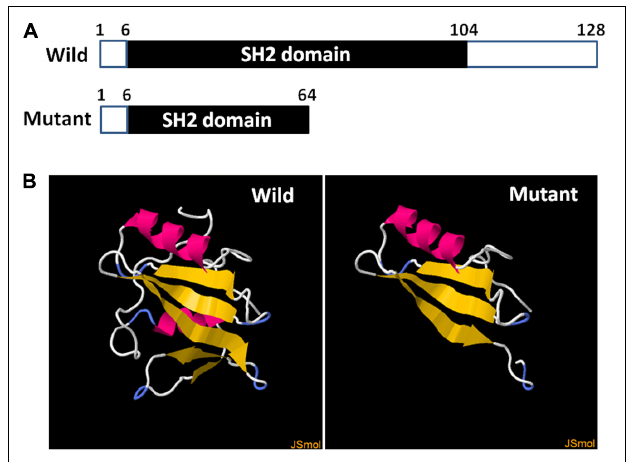
FIGURE 2 | Diagrammatic representation and prediction of the three-dimensional structure of wild and truncated SH2D1A. (A) The numbers above the bars correspond to the amino acid number. (B) The yellow strands represent β -strands and the pink strands represent the α -helixes. The three-dimensional structure of the truncated protein was completely disrupted after SH2D1A mutation (c.191G > A).